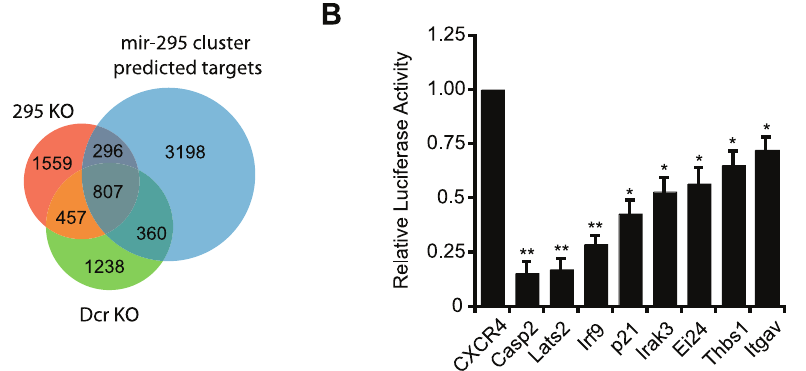
Figure 2. Microarray data and Targetscan predictions identify candidate miR-295 targets in mESCs. A. Venn diagram of microarray and target prediction data used to generate mir-295 cluster target candidates. ‘‘mir-295 cluster predicted targets’’ = predicted TargetScan targets of the miR-295 cluster; ‘‘295 KO’’ = genes that showed a 1.2 fold upregulation on mir-295 cluster loss; ‘‘Dcr KO’’ = genes that showed a 1.2 fold upregulation on Dicer loss. Only ES-expressed genes (i.e. genes with an expression of at least 16 on the wild type arrays) were considered for analysis. B. Activity of luciferase reporters of predicted targets of the mir-295 cluster were assayed in Dcr WT and Dcr KO ES cells. Luciferase reporters contain full length 3’ UTRs of predicted targets. Relative luciferase activity is the ratio of the reporter’s activity in WT ES cells and Dcr KO ES cells.